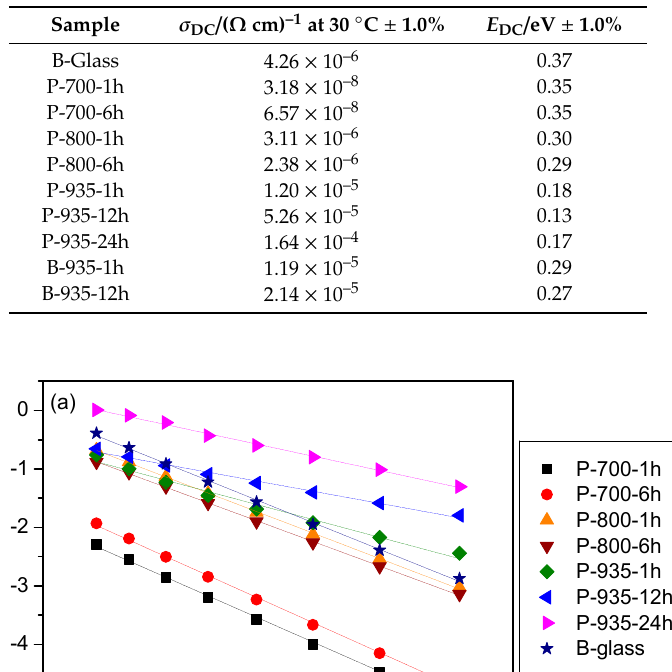
Table 2. DC conductivity, σ DC , at 30 ◦ C and activation energy, E DC , for parent 60WO 3 -40P 2 O 5 bulk glass and prepared glass-ceramics.